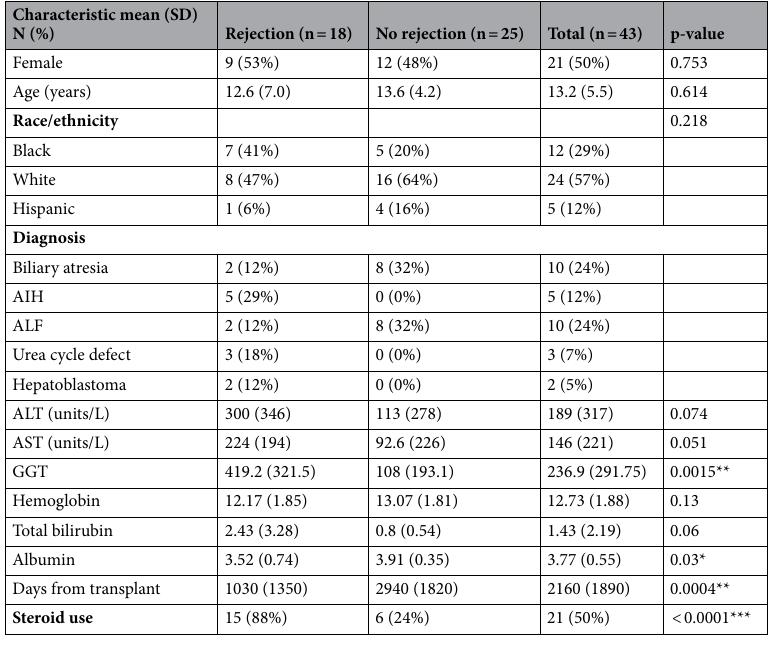
Table 1. Participant demographics by rejection status. SD, standard deviation; AIH, autoimmune hepatitis; ALF, acute liver failure; ALT, alanine aminotransferase; AST, aspartate aminotransferase; GGT, gamma glutamyltransferase. *p-value < 0.05; **p-value < 0.001; ***p-value <